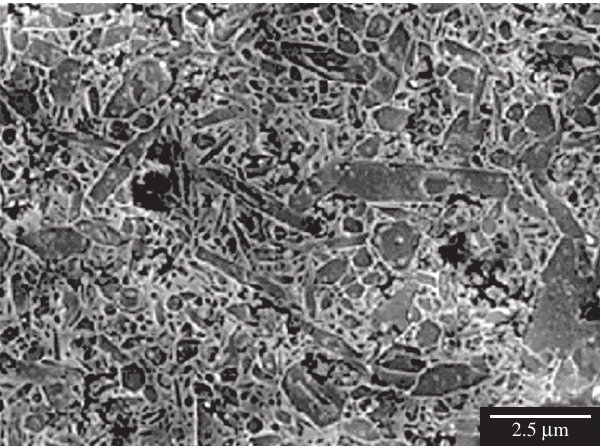
Figure 1. Scanning electron micrograph (SEM) of polished and etched sample surface of silicon nitride.